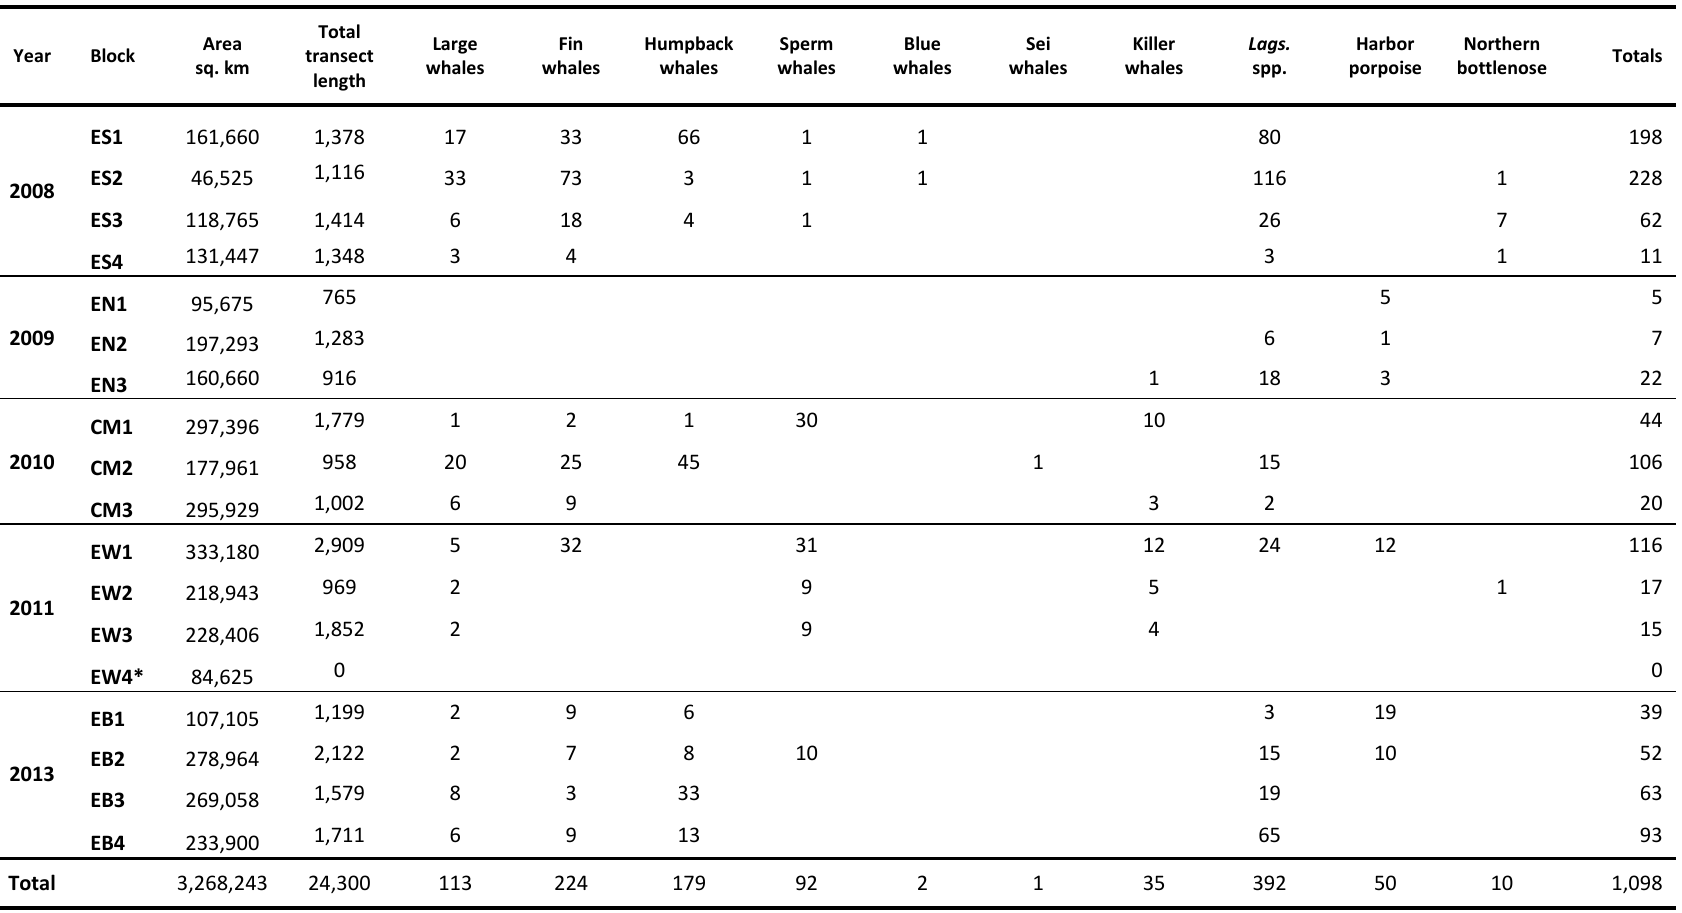
Table 3. Summary of effort and sightings for the 2008 – 2013 survey for all species by survey block and